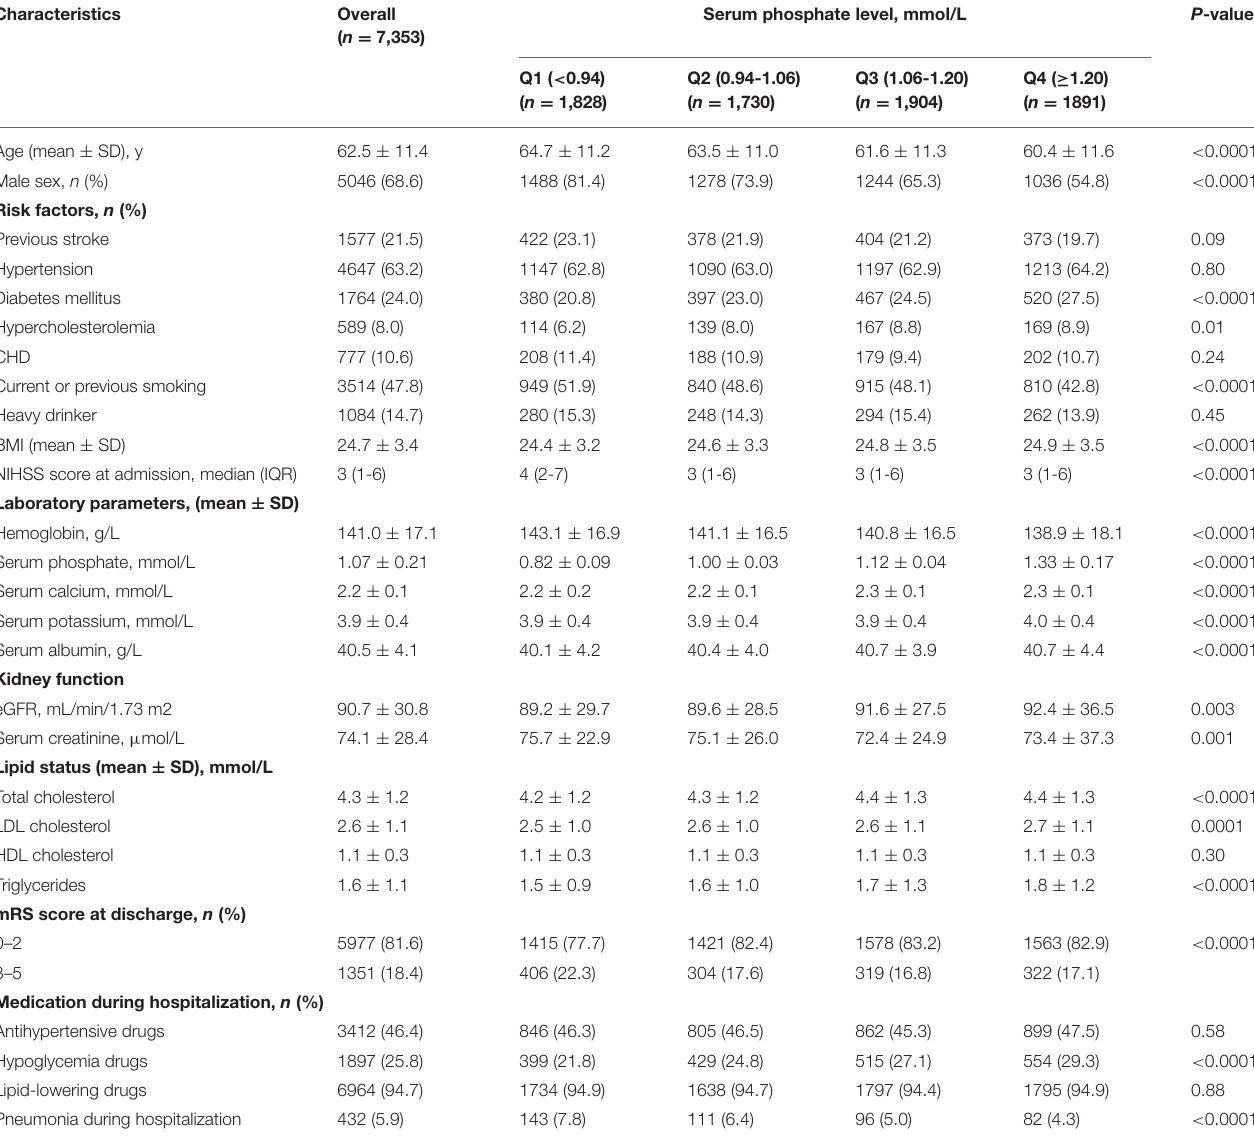
TABLE 1 | Baseline characteristics of the patients according to quartiles of serum phosphate level.